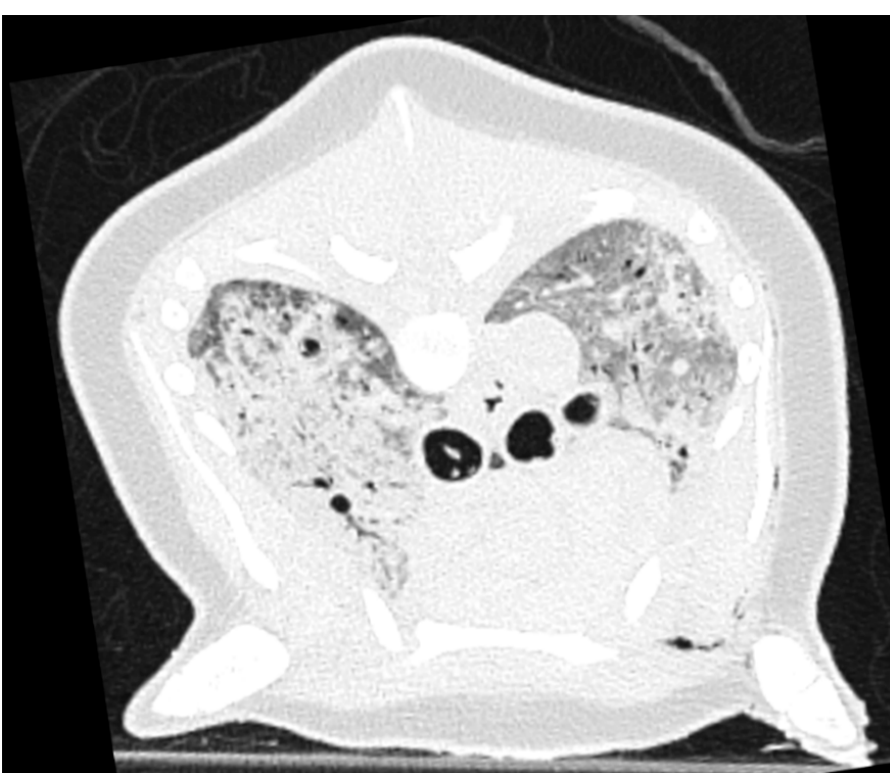
Figure 4. Example of an asymmetric gradient of pulmonary soft tissue attenuation found on PMCT, with signs of associated thoracic wall flattening on the left side of the image, likely consistent with positional-dependent hypostatic edema.